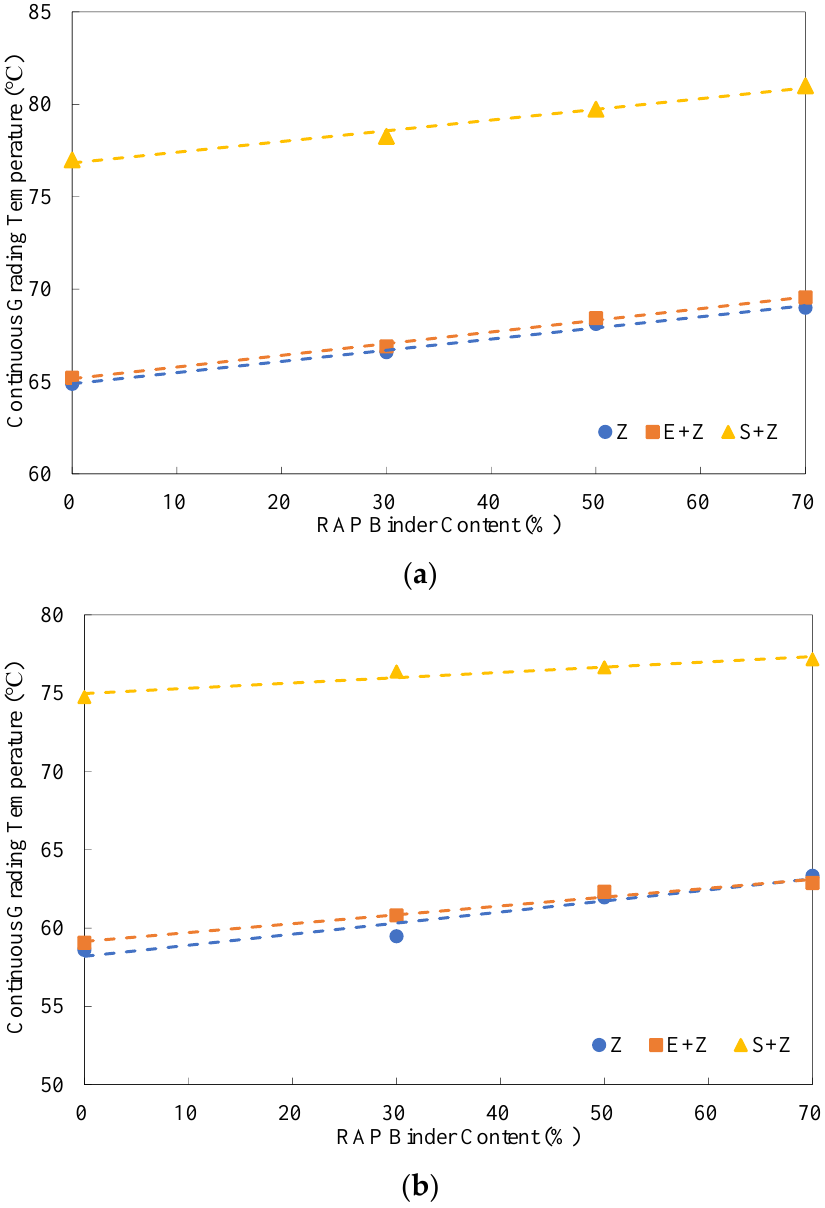
Figure 13. High-temperature continuous grading temperatures of the warm-mix recycled binders at different RAP binder contents: ( a ) original; ( b ) RTFO-aged.